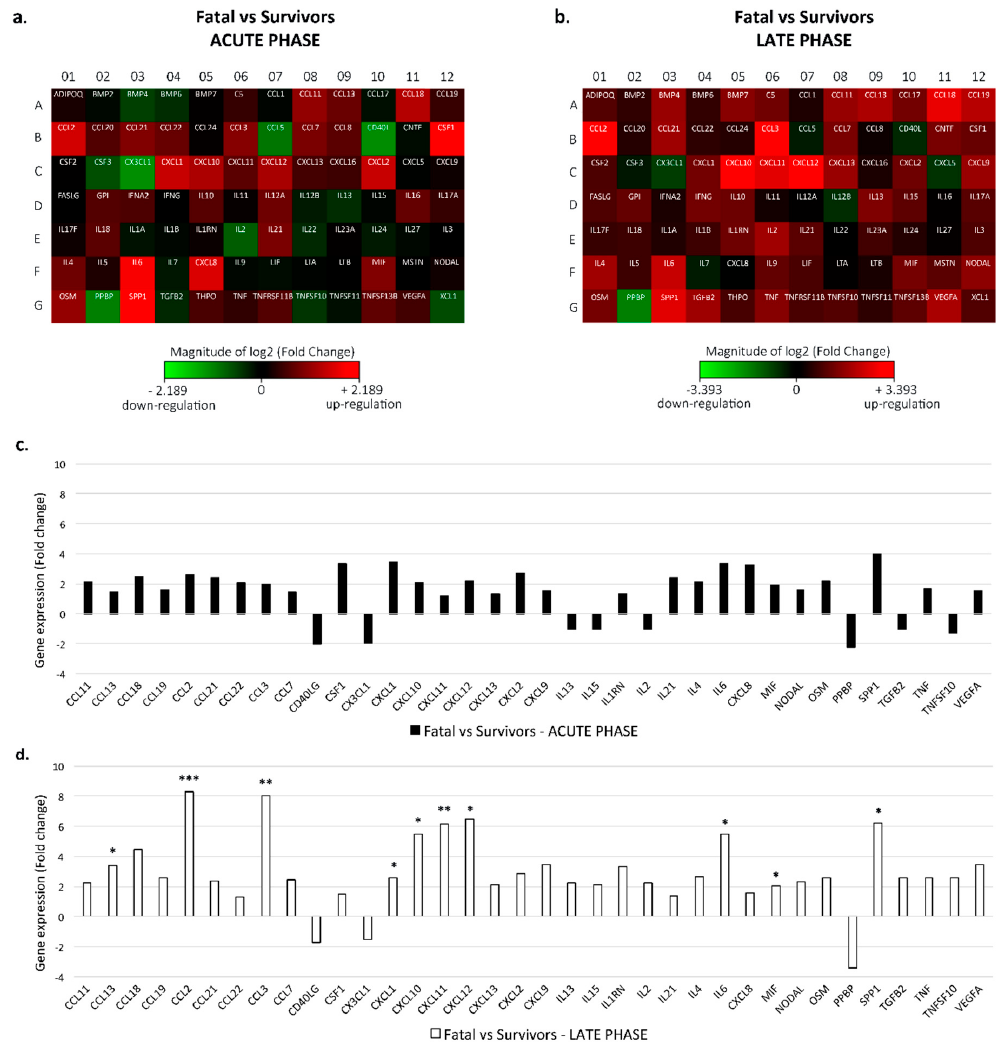
Figure 1. mRNA levels of 84 cytokine in EBOV-fatal compared to EBOV-survivor patients during the acute and late phases of infection. ( a , b ) Heat-maps of the fold change in mRNA levels of a panel of cytokines in 23 EBOV-fatal samples as compared to 19 EBOV-survivor samples during the acute phase ( a ); and 15 EBOV-fatal samples as compared to 18 EBOV-survivor samples during the late phase ( b ) of infection. Fold changes ≥ 2 (upregulation, red) or < − 2 (downregulation, green) are shown. ( c , d ) Up- or down-regulation of cytokines mRNA levels in fatal versus survivor EVD patients during the acute ( c ) and late ( d ) phases of infection. The data are reported as positive (up-regulation) or negative (down-regulation) mean fold changes observed during the acute (black bars) and late phase of infection (white bars). Only cytokines for which the fold change was more than 2 (up-regulation) or less than − 2 (down-regulation) were considered. Significant statistical differences in mRNA levels ( ∆ Ct) between the two groups are reported (* p < 0.05, ** p < 0.01, *** p < 0.001 in Mann–Whitney test). During the acute phase, there were no significant (2-fold) differences in the mRNA expression The correlation between the level of each cytokine mRNA with the corresponding EBOV viremia levels of immune mediators in fatal patients versus survivors. Moreover, of the 84 analyzed factors, levels was evaluated. A statistically significant ( p < 0.05) correlation was observed only in the fatal 16 (19%) showed ≥ 2-fold variation in gene expression in fatal as compared to the survivor group, group during the late phase of infection (Table 1). In particular, a strong ( r ≥ ± 0.6) positive correlation with EBOV viremia was observed in those genes which were mainly involved in leukocytes recruitment and activation. Among these, the chemokines CCL2 and CXCL12 resulted in high correlation values ( r = 0.859 and = 0.8206 respectively; p < 0.0001), suggesting a link between the prolonged viral replication and the sustained signaling of chemotaxis for lymphocytes and macrophages and